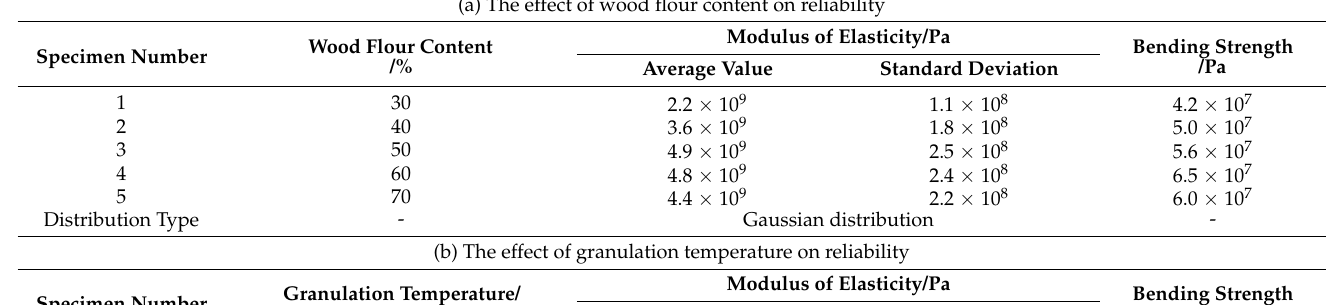
Table 2. Simulation performance parameters for the effect of each variable on reliability. (a) The effect of wood flour content on reliability